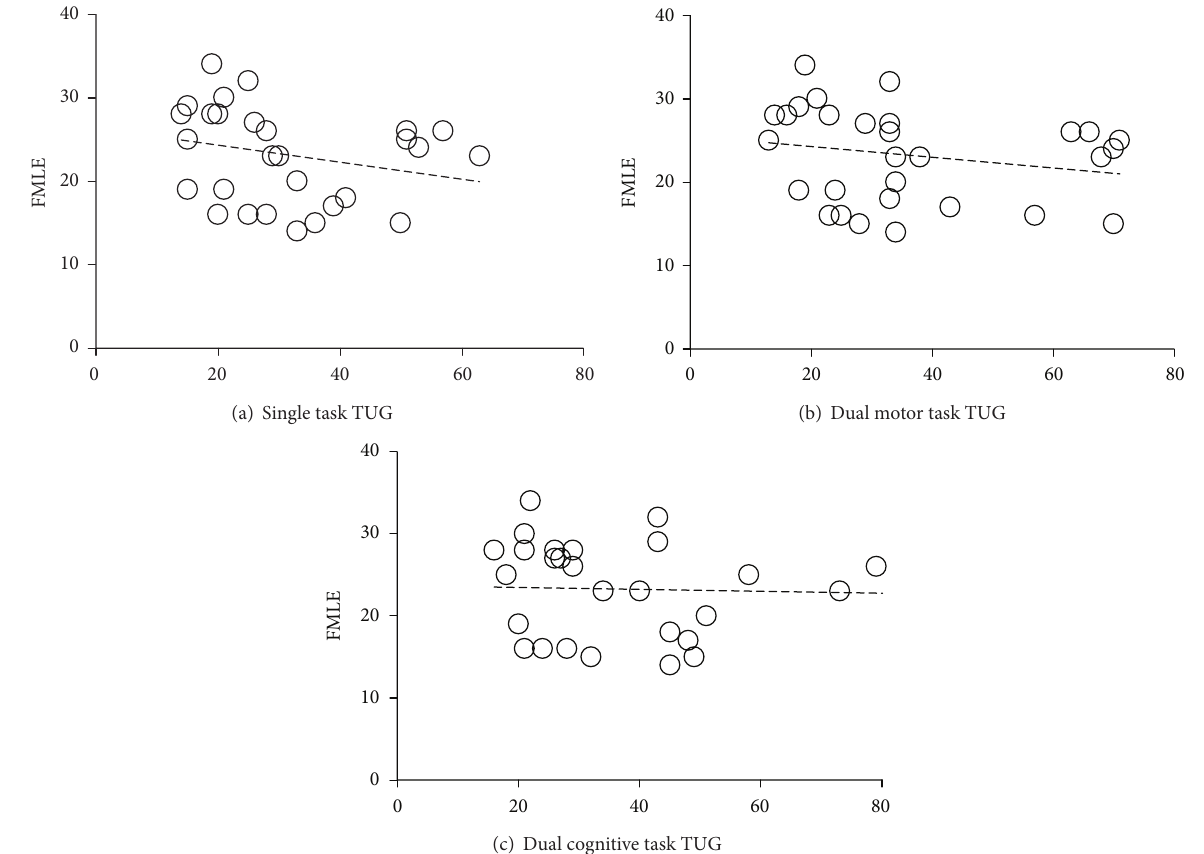
Figure 5: Scatter plots between Fugl-Meyer lower extremity motor (FMLE) scores and time to complete Timed Up and Go (TUG) test across three attentional loading conditions. (a) Single task TUG, (b) dual motor task TUG, and (c) dual cognitive task